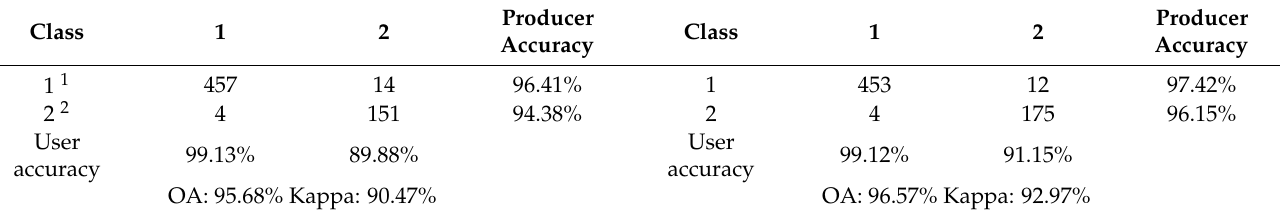
Table 6. Algorithm accuracy verification.